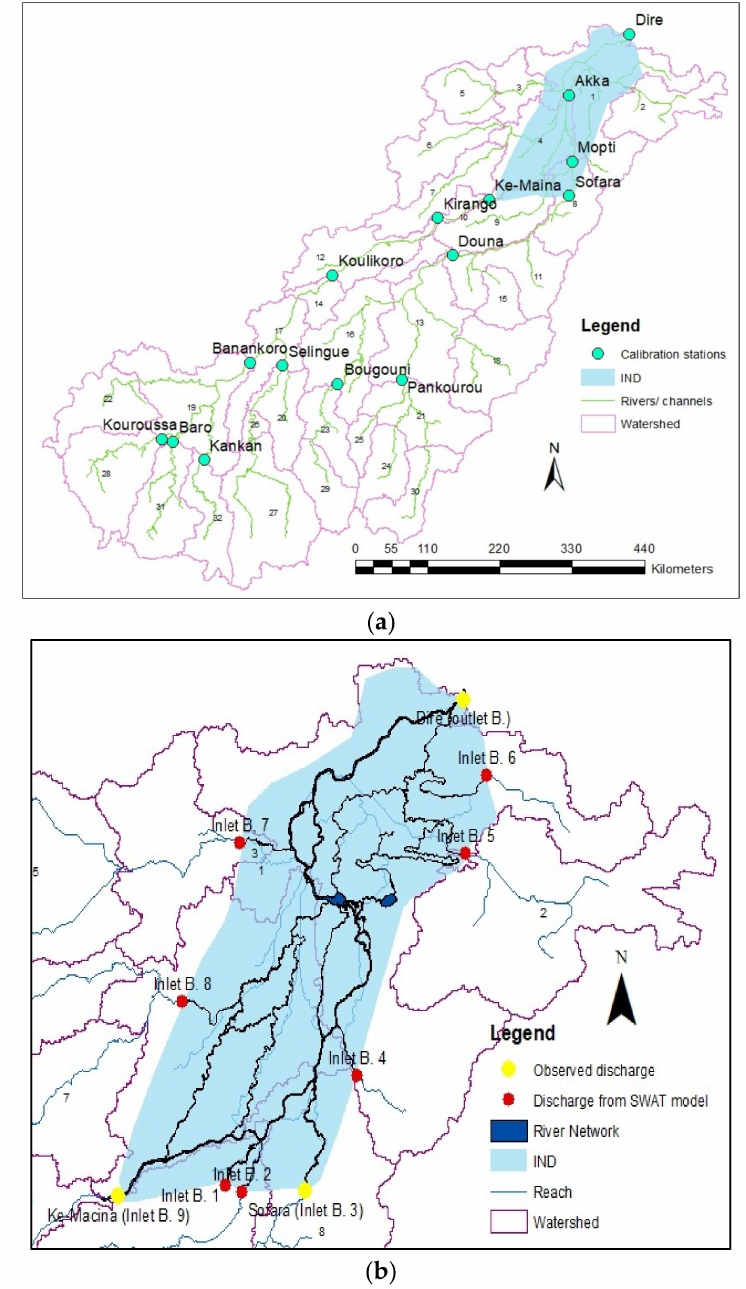
Figure 6. ( a ) Extent of the SWAT model with calibration stations (Source: Seidou, 2019) and ( b ) locations of the liquid boundaries in the hydrodynamic